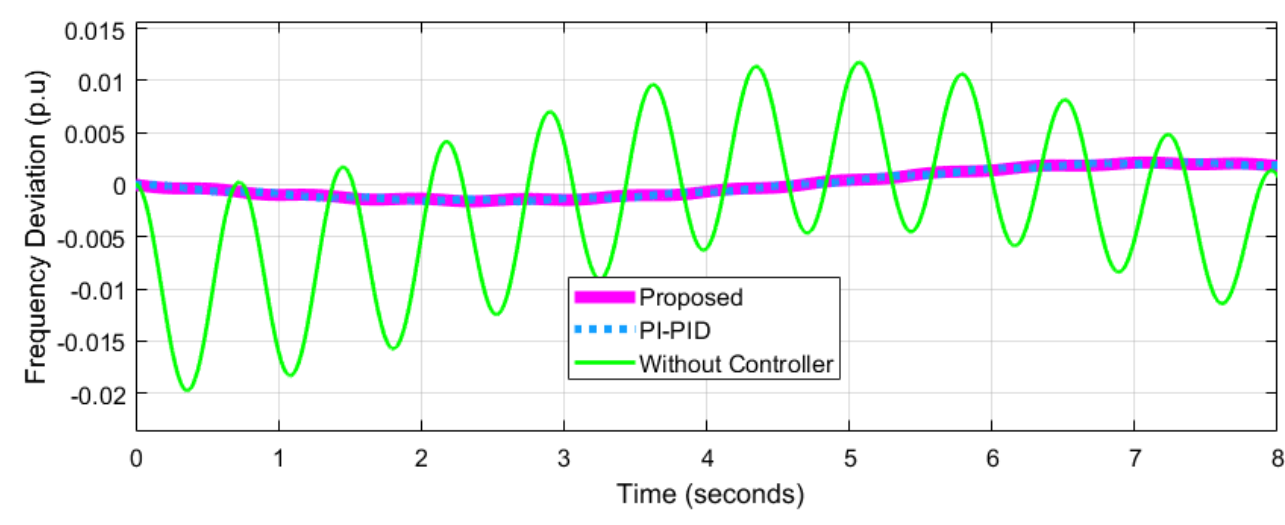
Figure 9. Case 2: frequency deviation at (K p = −1.8703, K i = −0.0051) for network 2.